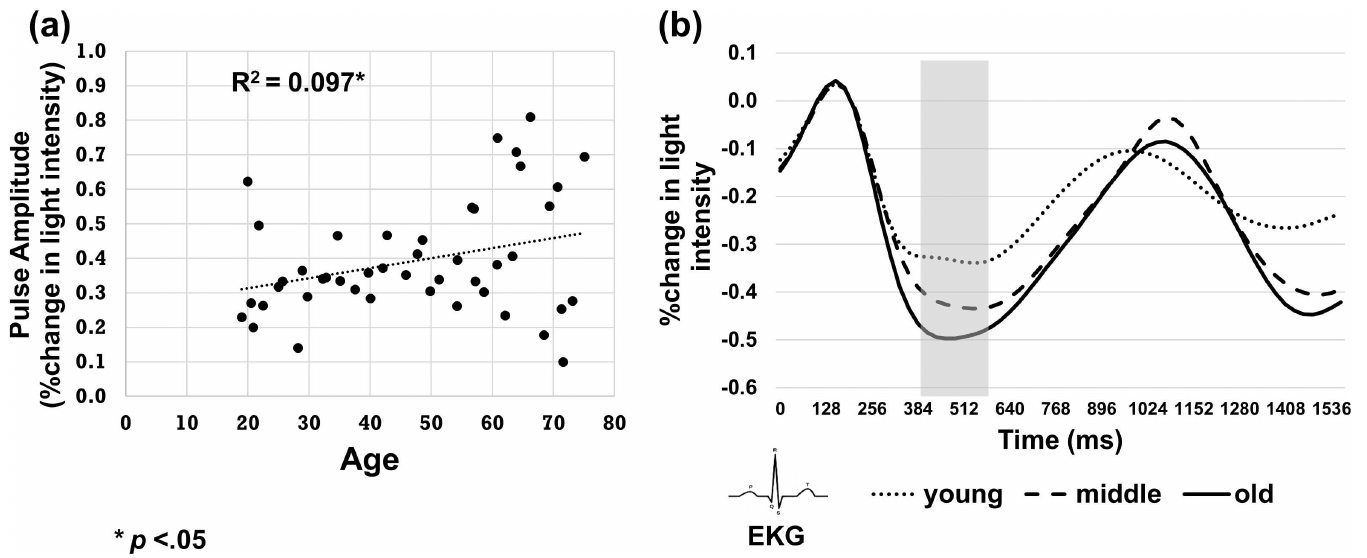
Fig 4. (a) Scatter plot showingthat older age is associated with larger pulse amplitude(expressed as percent change in light intensity). (b) Average pulse waveforms split into age tertiles. The transparentgray bar indicatesthe time interval in which pulse amplitudevalues were extracted and